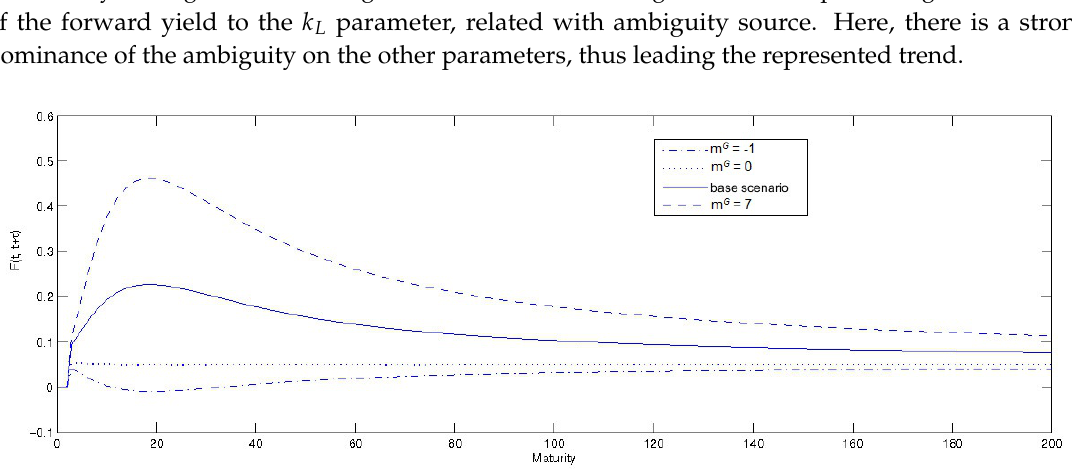
Figure 17. Forward yield in different scenarios of government actions.